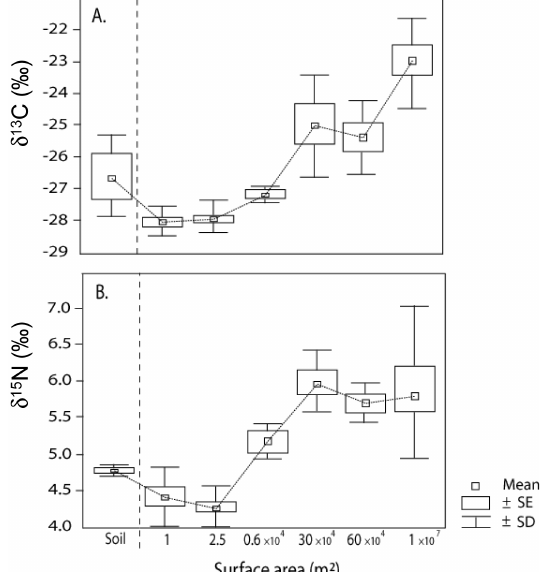
Figure 3. Box plot of δ 13 C (A) , δ 15 N (B) for the bulk soil and for sediments collected at the different spatial scales under study. Mean values, standard errors and standard deviations were computed from the different plot repetitions and from the 34 rainfall events under study.